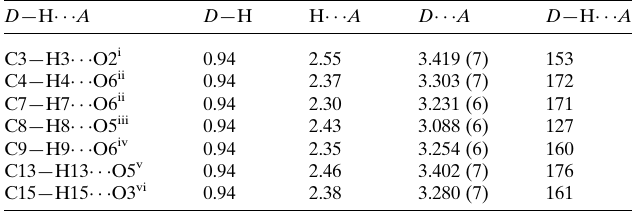
Table 1 Hydrogen-bond geometry (A˚ , (cid:4) ).